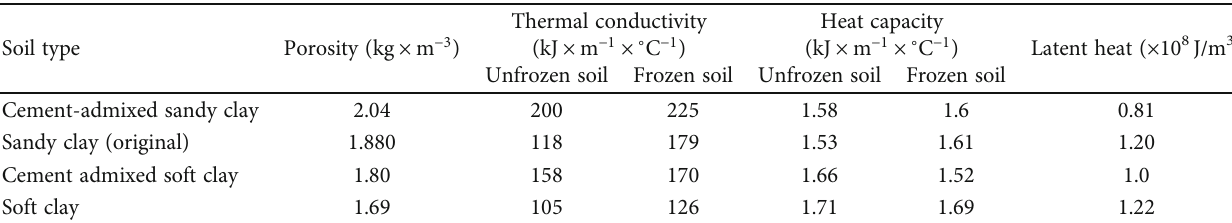
Table 3: Parameters of soil